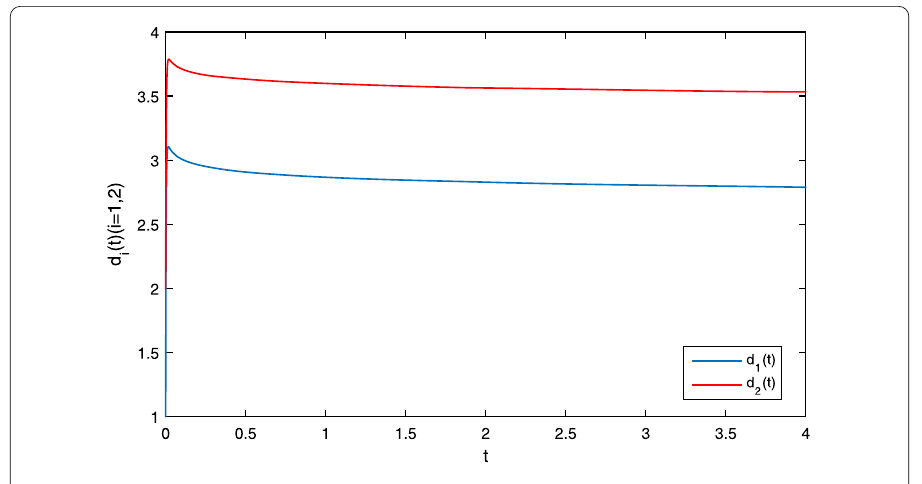
Figure 11 Time response of d i ( t ) ( i = 1,2) with β = 3